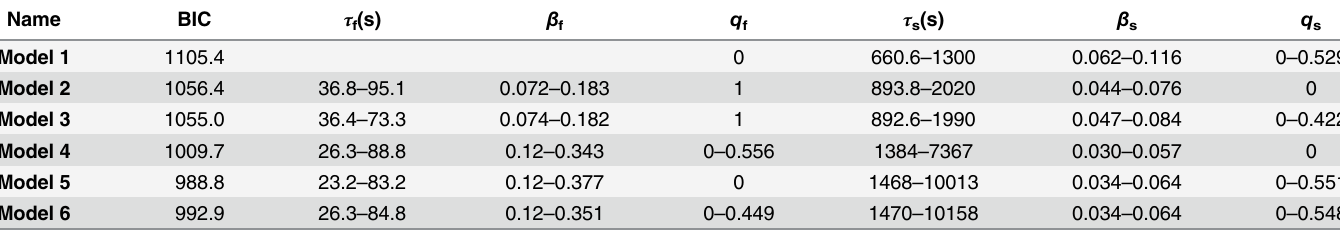
Table 2. Results of the model comparison analysis. For the tested models described in Table 1, BICs and the confidence intervals of the estimated parameters from 10,000 bootstrapped data sets were presented. BIC of models 4, 5, 6 with interference parameter(s) was significantly lower than that of the other